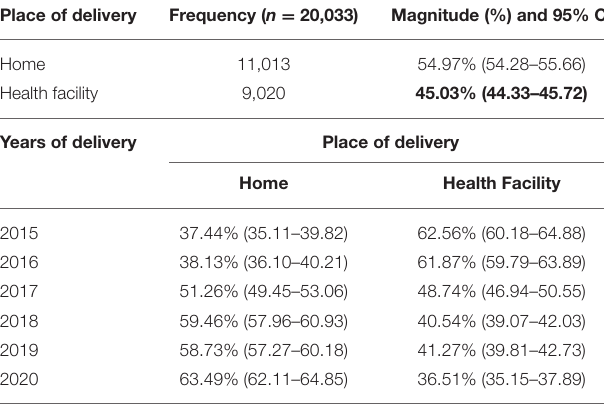
TABLE 3 | Magnitude of institutional delivery in Kersa HDSS from 2015 to